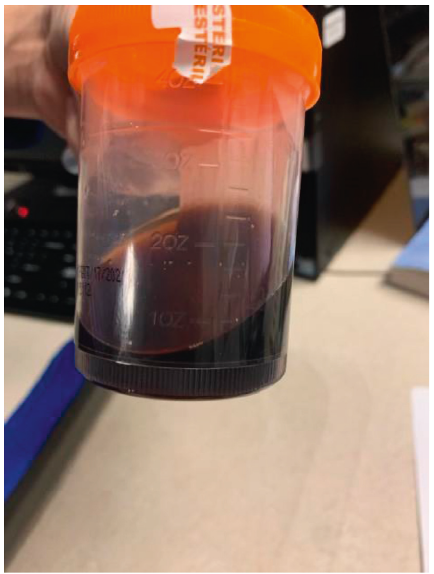
Figure 1: Urine sample on admission demonstrating large blood but only minimal red blood cells (25–50) per high-power field with dark brown color. This is consistent with hemoglobinuria, one of the classic presentations of childhood PCH [1,